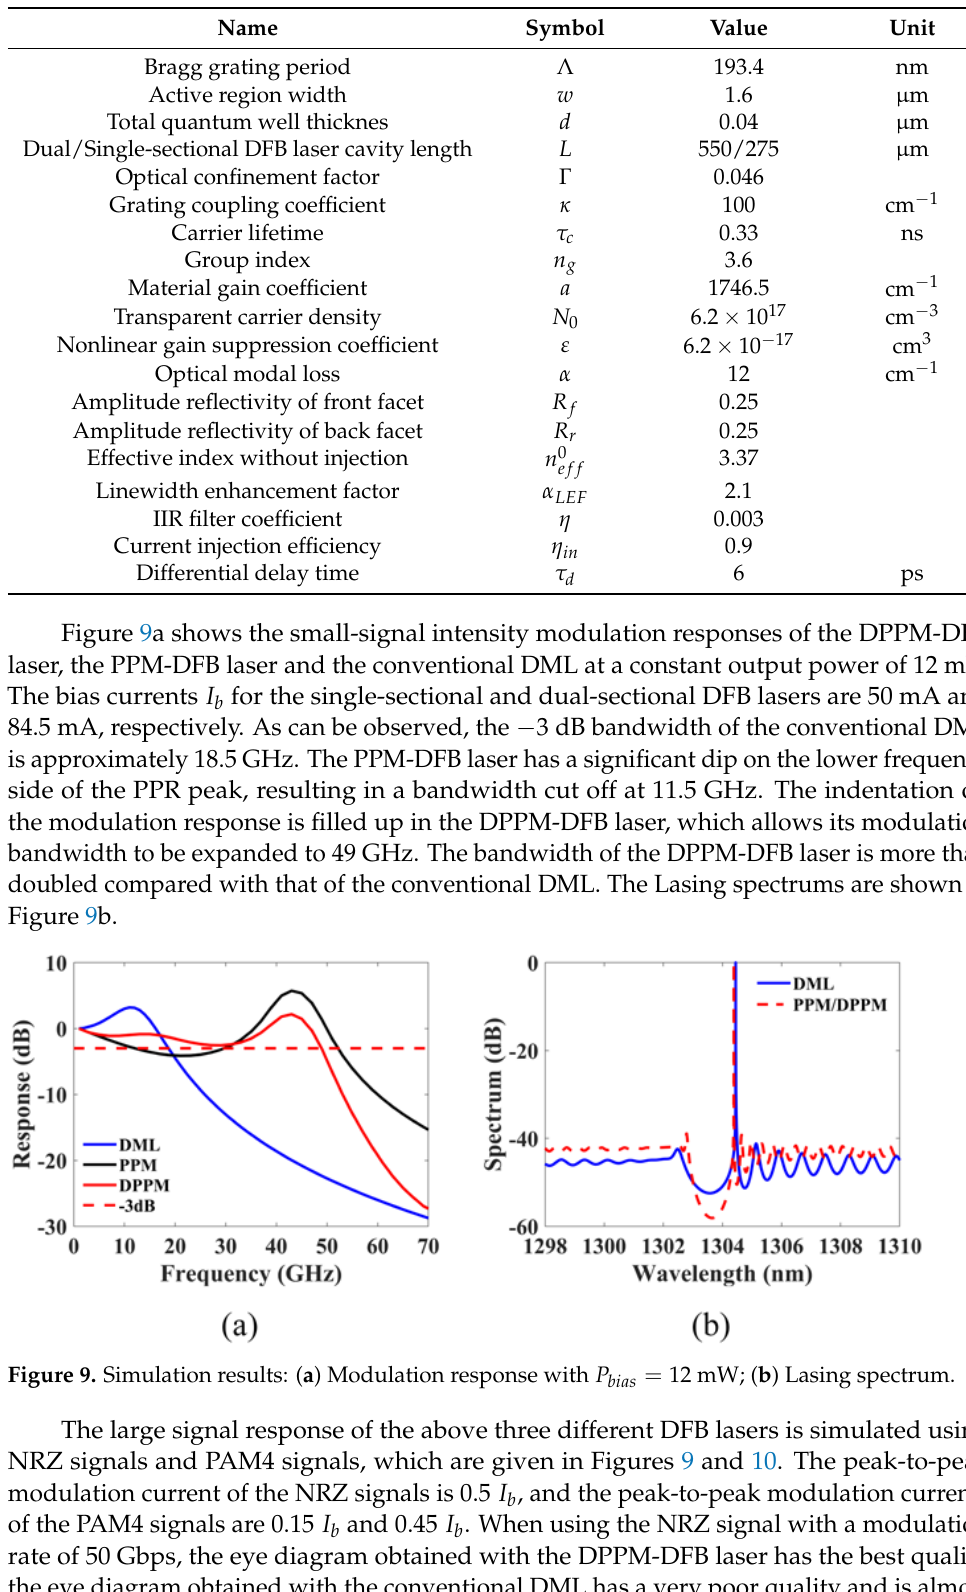
P mW ; ( b ) Lasing spectrum. bias